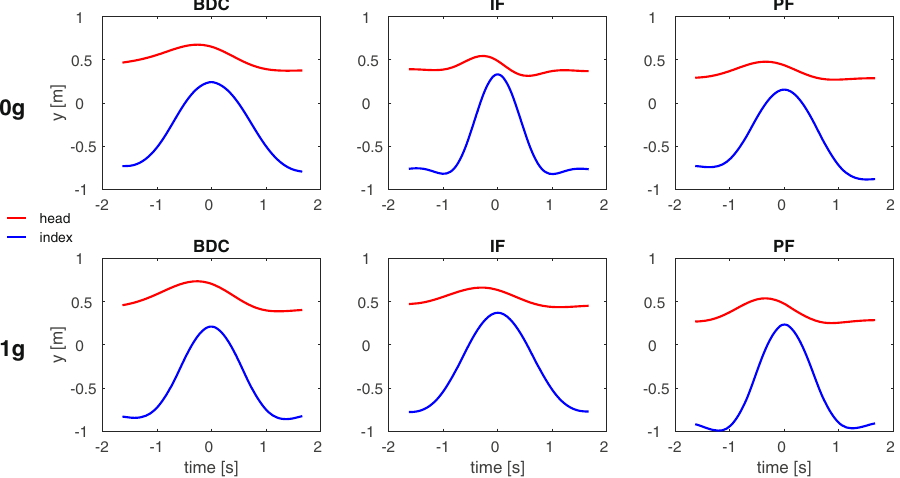
Fig. 8 Head and index fi nger motion. Head and index motion for throwing to the ceiling. Red: time course of the intersection of the ear-eye line with the virtual ball path along the “ vertical ” . Blue: time course of the “ vertical ” position of the index fi nger. Data were averaged over all trials performed pre- fl ight, in- fl ight, and post- fl ight by participant